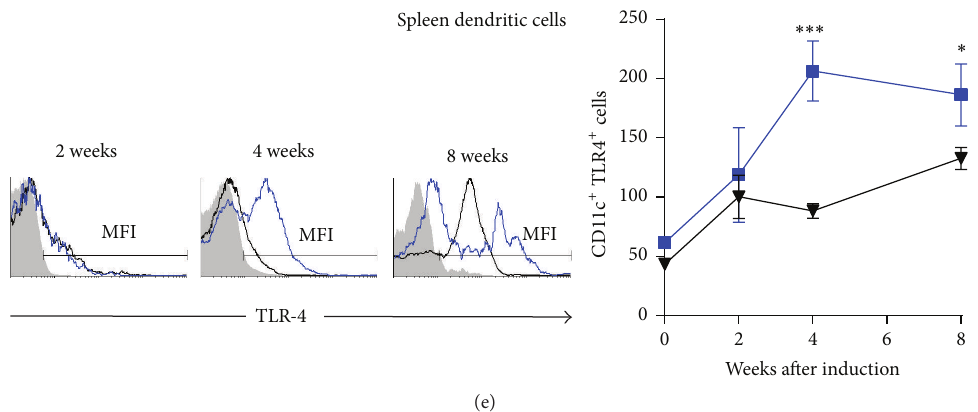
Figure 6: Mif promotes costimulatory molecules expression on spleen DC. The time course of costimulatory molecule: CD80 (a), CD86 (b), MHC-II (c), TLR-2 (d), and TLR-4 (e) expression on spleen CD11c + DC. DC from spleen of Wt and Mif − / − mice were harvested at 0, 2, 4, and 8 weeks after STZ administration and 1 × 10 7 cells/mL were processed by flow cytometric analysis as indicated in Section 2. Analyses of expression are shown in the right panels: WtSTZ ( ◼ ); Mif − / − STZ ( 󳶃 ). And representative histograms of expression based on fluorescence are shown in the left panels. Isotype controls are indicated in gray shadow, the black line represents expression by Mif − / − STZ cells, and the blue line shows expression by WtSTZ cells. The data are presented as the mean fluorescence intensities (MFI) from one representative experiment. Each experiment was repeated three times ( 𝑛 = 3 ) and individually analyzed. ∗ 𝑝 < 0.05 , ∗∗ 𝑝 < 0.01 , or ∗∗∗ 𝑝 < 0.001 , GraphPad Prism software